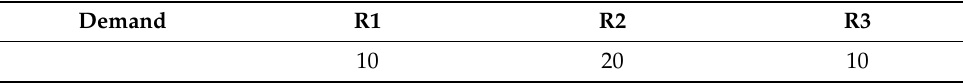
Table 3. Demanded quantity of products from the retailer